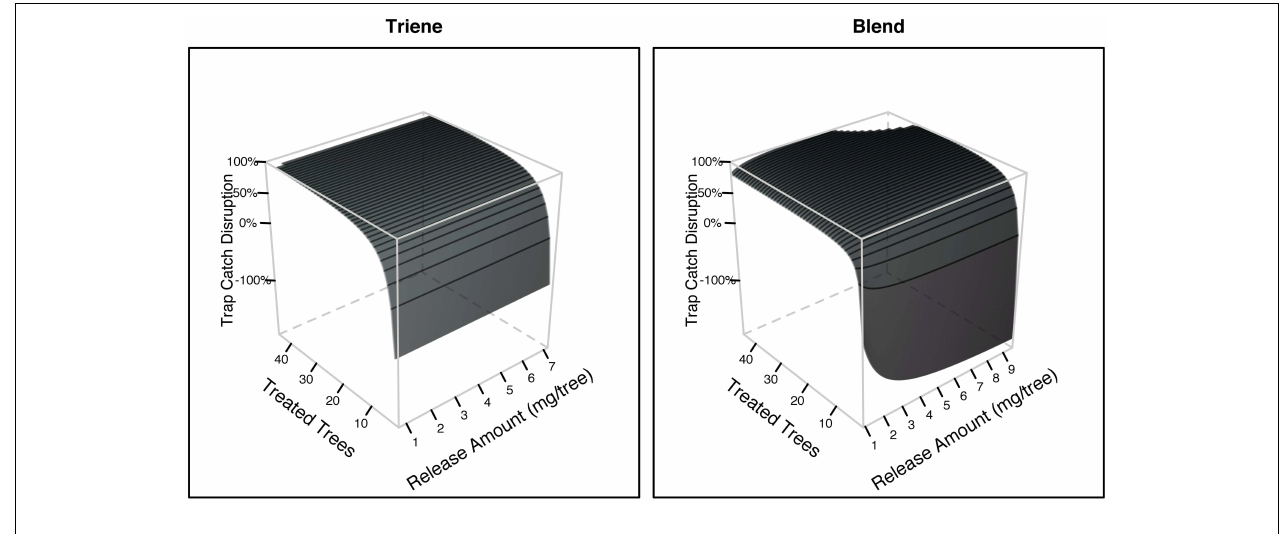
FIGURE 6 | Trap catch disruption response surfaces derived from field data for both the 3:1 triene:diene blend (attractive) and triene only (non-attractive) treatment. Treated trees are the number of individual